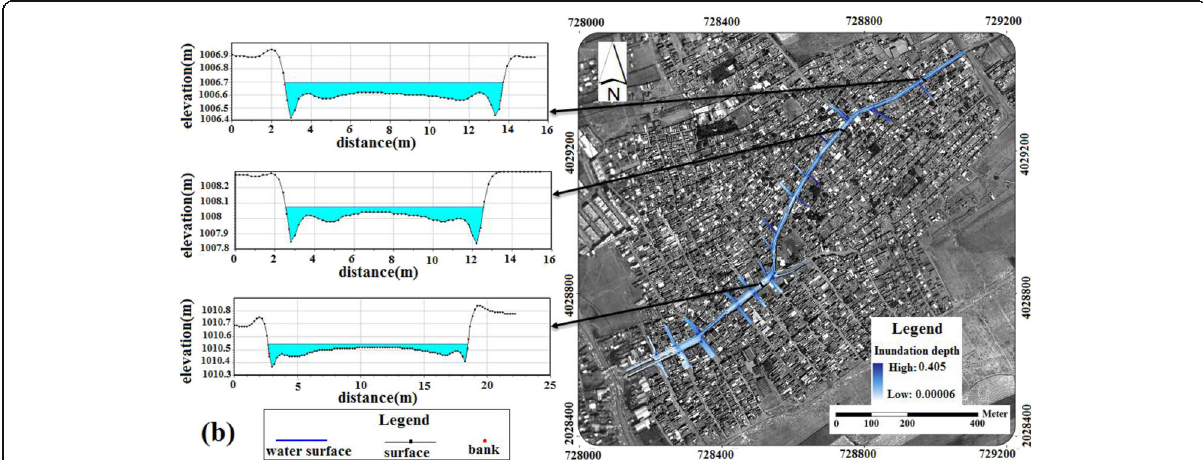
Fig. 9 Inundation zone map and water depth at cross sections profiles in 25 year return